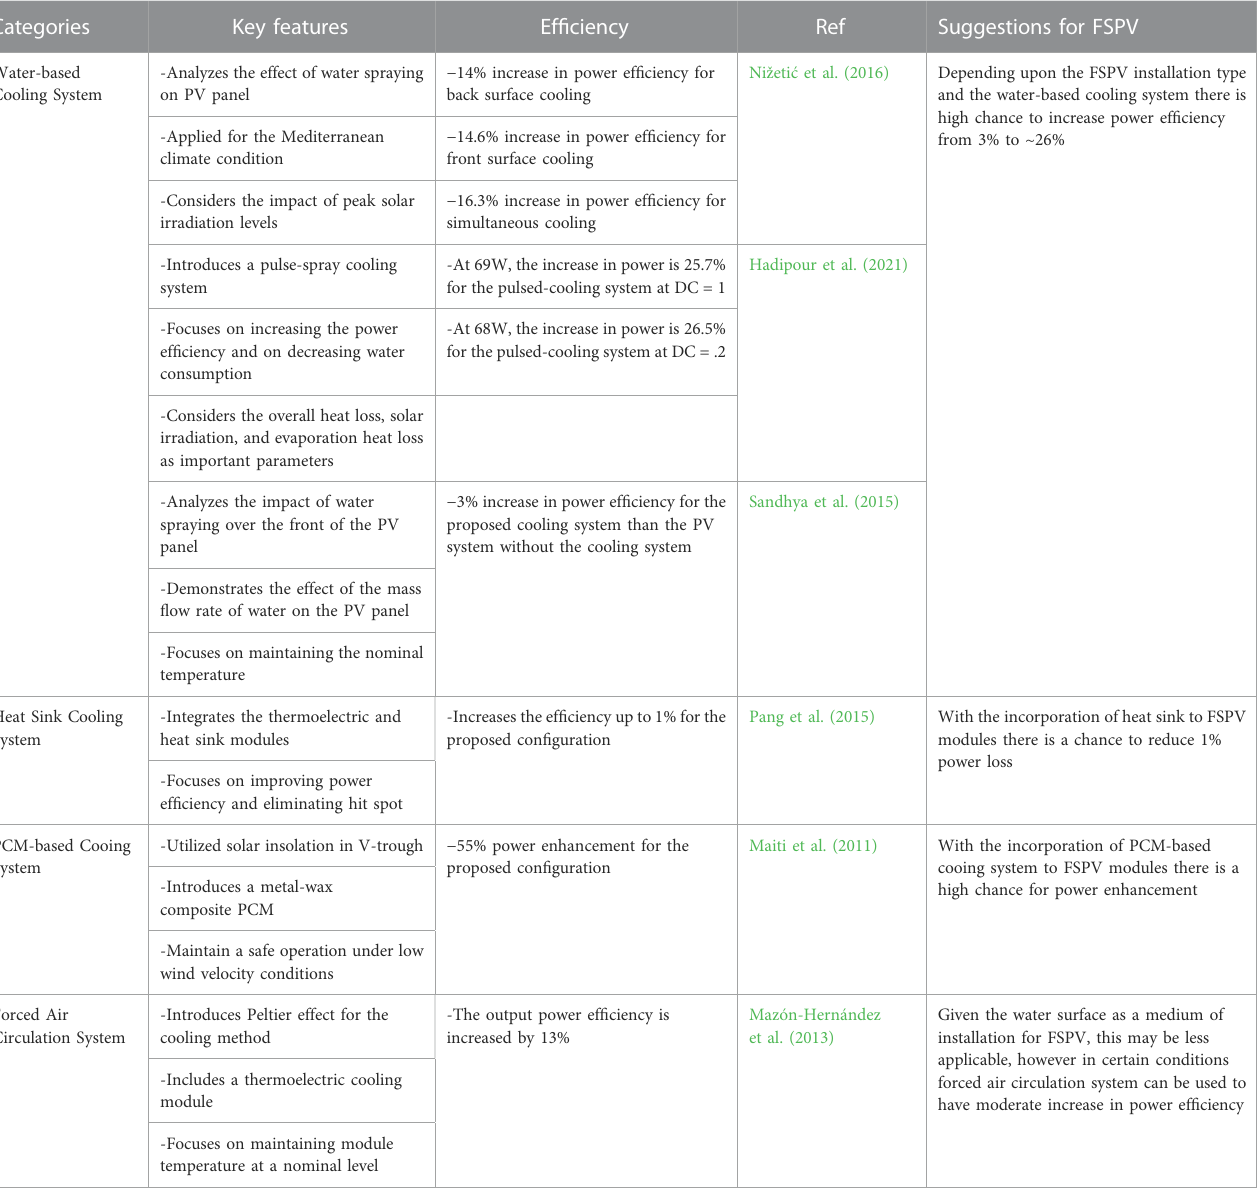
TABLE 4 Summary of different cooling techniques highlighting their key features and ef fi ciency improvements along with applicability for FSPV.